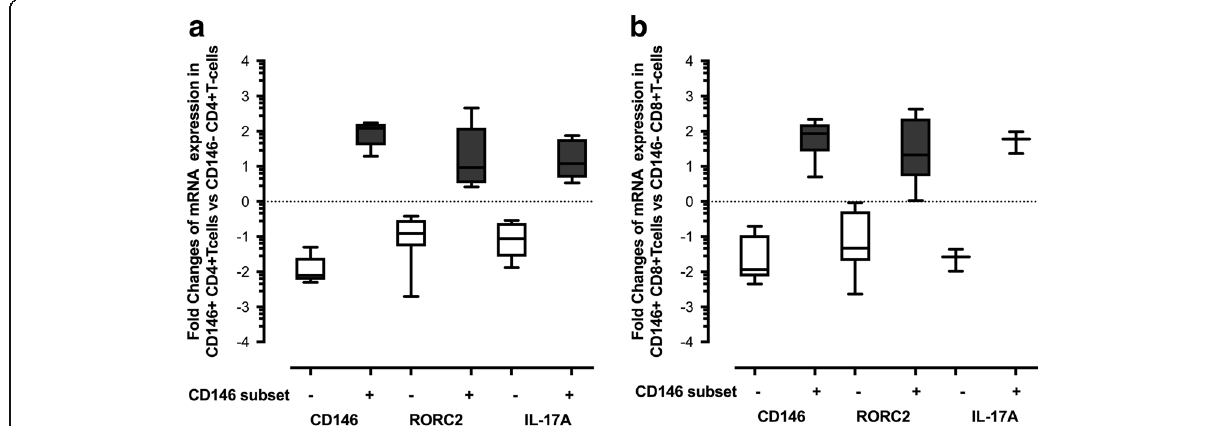
Fig. 2 QRTPCR of mRNA isolated from sorted CD4 + CD146+ and CD8 + CD146+ T cells: RNA was isolated from freshly sorted lymphocytes derived from healthy individuals ( n = 5), and cDNA was prepared as described and QPCRs for CD146, RORc2 and IL-17A were performed. Fold changes were normalized mRNA levels with housekeeping gene ( β -actin) for ( a ) CD4+CD45RO+CD146+ and ( b ) CD8+CD146+ T cells were